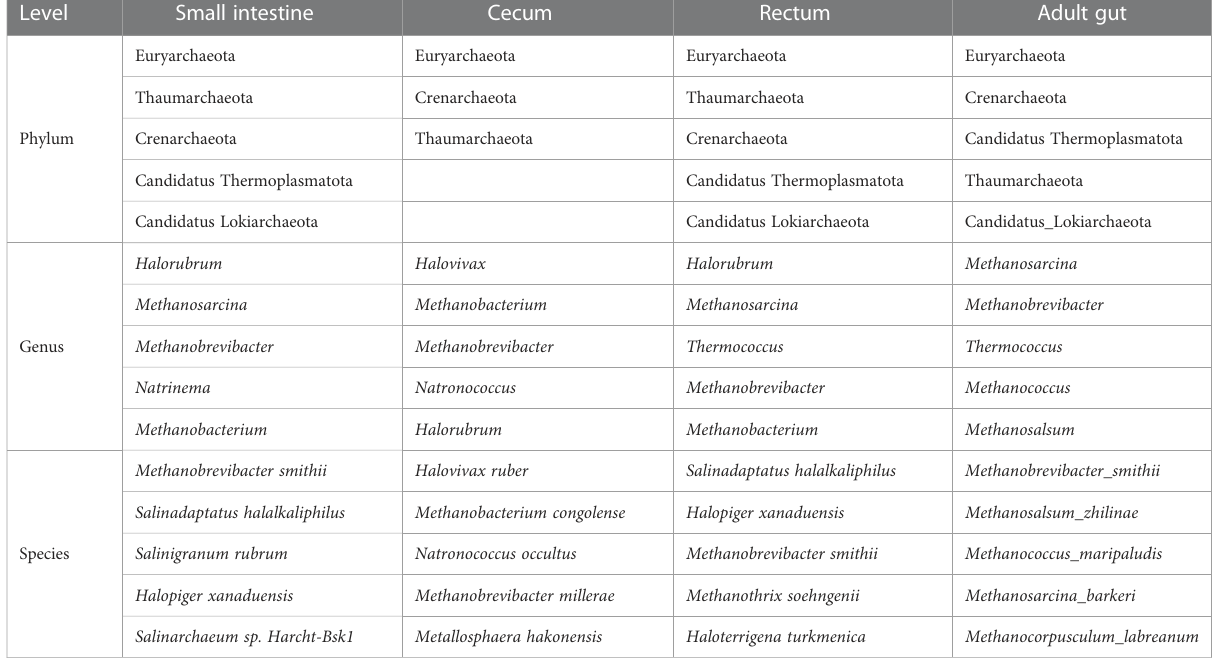
TABLE 3 Top 5 archaea at phylum, genus and species level